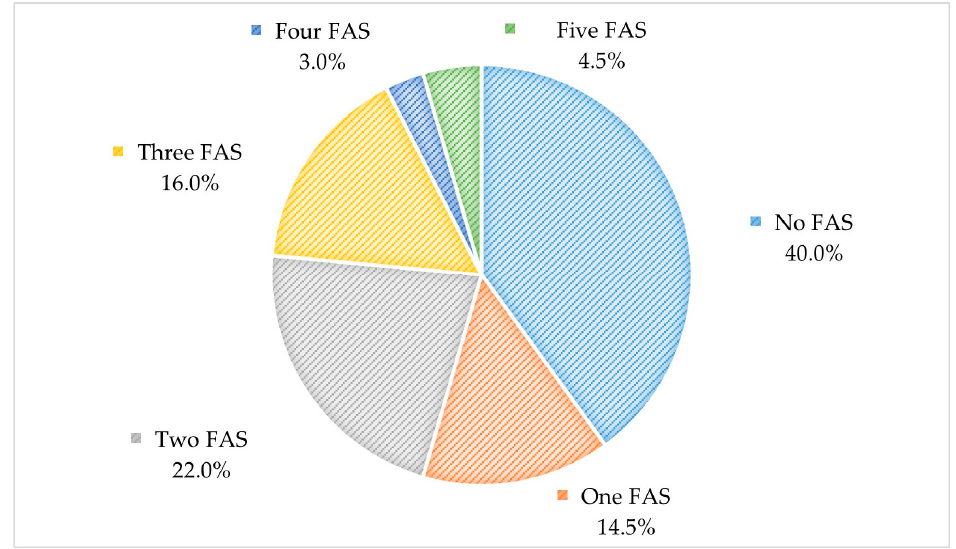
Figure 4. Polysensitization patterns to fungal aeroallergens in the studied patients by immunoblot assay (N = 200). FAS, fungal aeroallergen sensitization.